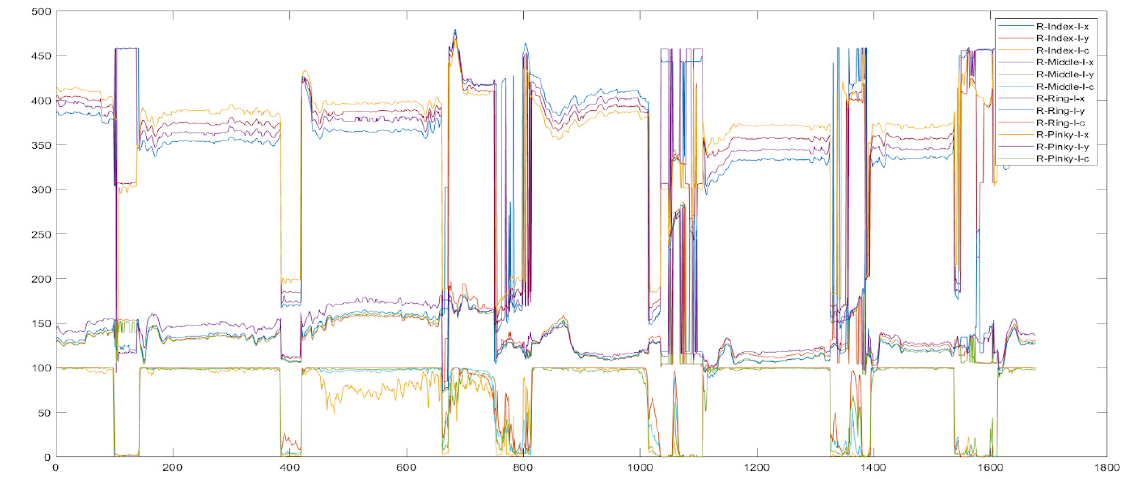
Figure 13. Movements of an infant’s hand on the HUGS ‐ 2 toy bar.